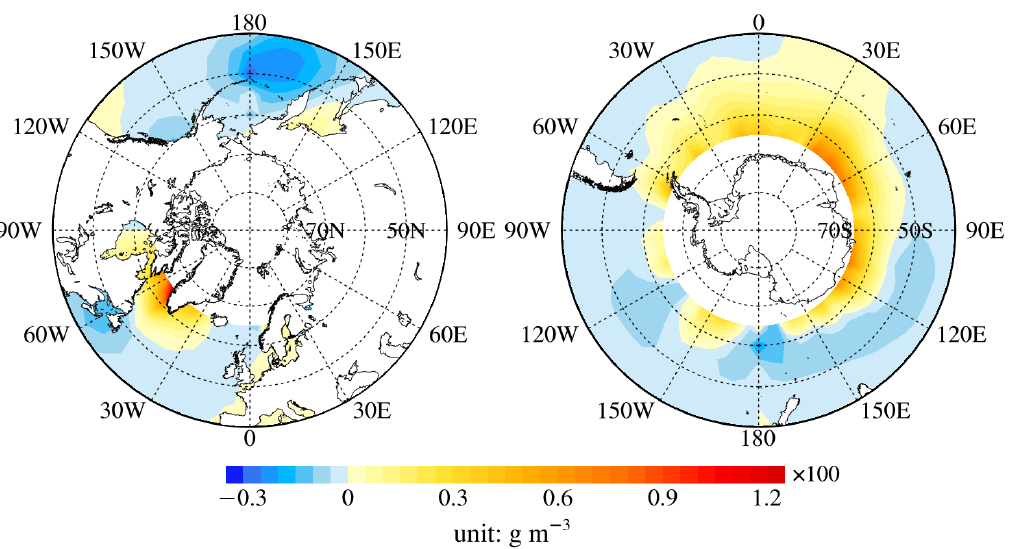
Figure 5. Differences in annual mean surface snow water content distributions over oceans for the one year of 2016 between CPR and DPR (CPR minus